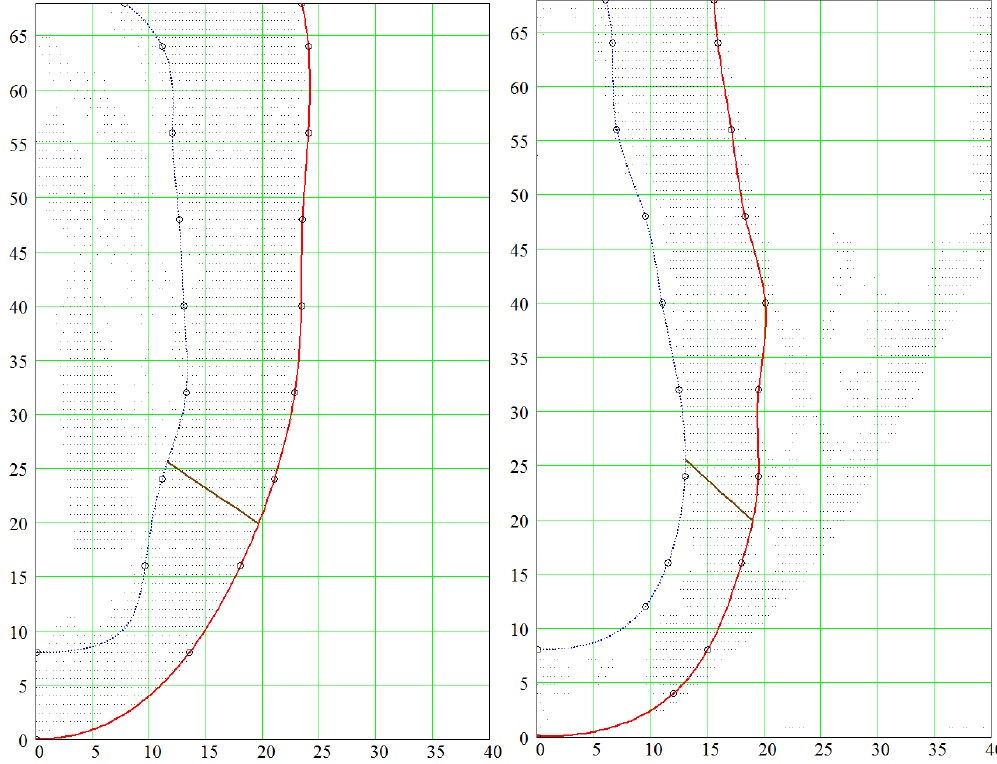
Figure 1. Vertical (meridional) sections of the LV free wall (on the left ) and the IVS (on the right ) of a human heart. The points represent DT-MRI data; the solid red line represents the model epicardium; the dashed blue line represents the model endocardium. The circles show the interpolation (marked) points given by a user. The horizontal axis is ρ ; the vertical axis is z . On the right panel, we see a papillar muscle in the RV cavity (vertical one, ρ = 25, . . . ,45 mm) and an RV free wall